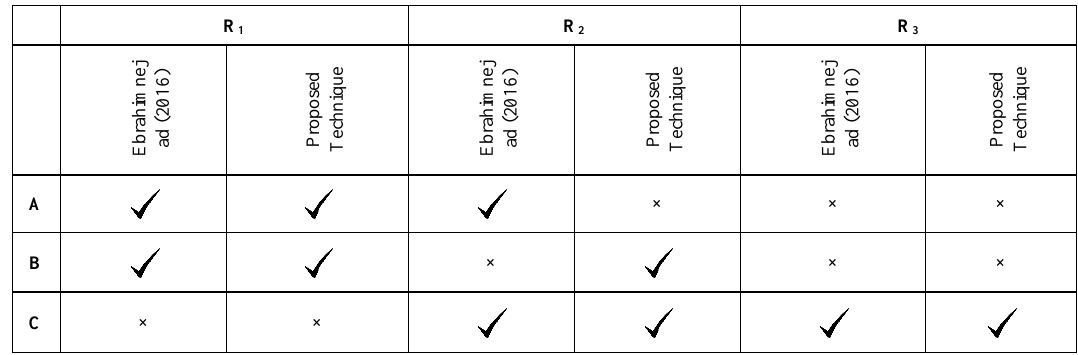
Table 15. Comparative study of Example